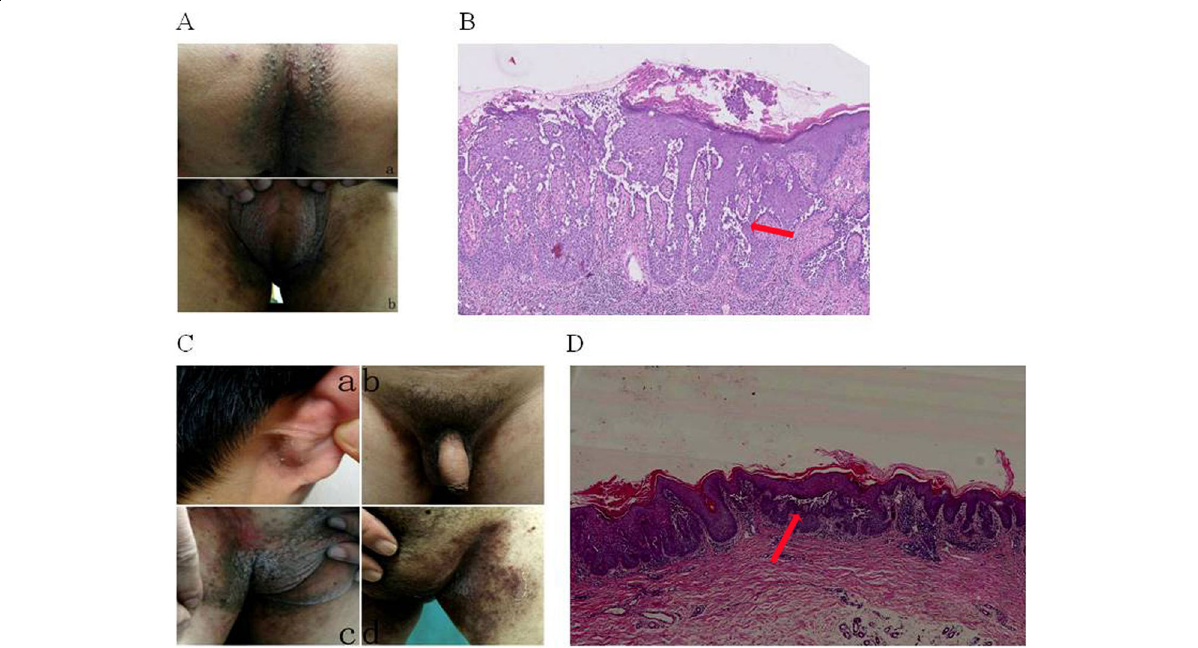
Fig. 2 Clinical data of sporadic case I and II. (A) Clinical manifestations of sporadic case I. Skin lesions were present in the anus (a) and groin (b). (B) Histopathological examination of typical skin lesion for sporadic case I (5×) (Arrow shows acanthosis). (C) Clinical manifestations of sporadic case II. Skin lesions were present in the right back of the ear (a) and bilateral groin (b; c, left, d, right). (D) Histopathological examination of typical skin lesion for sporadic case II (5×) (Arrow shows